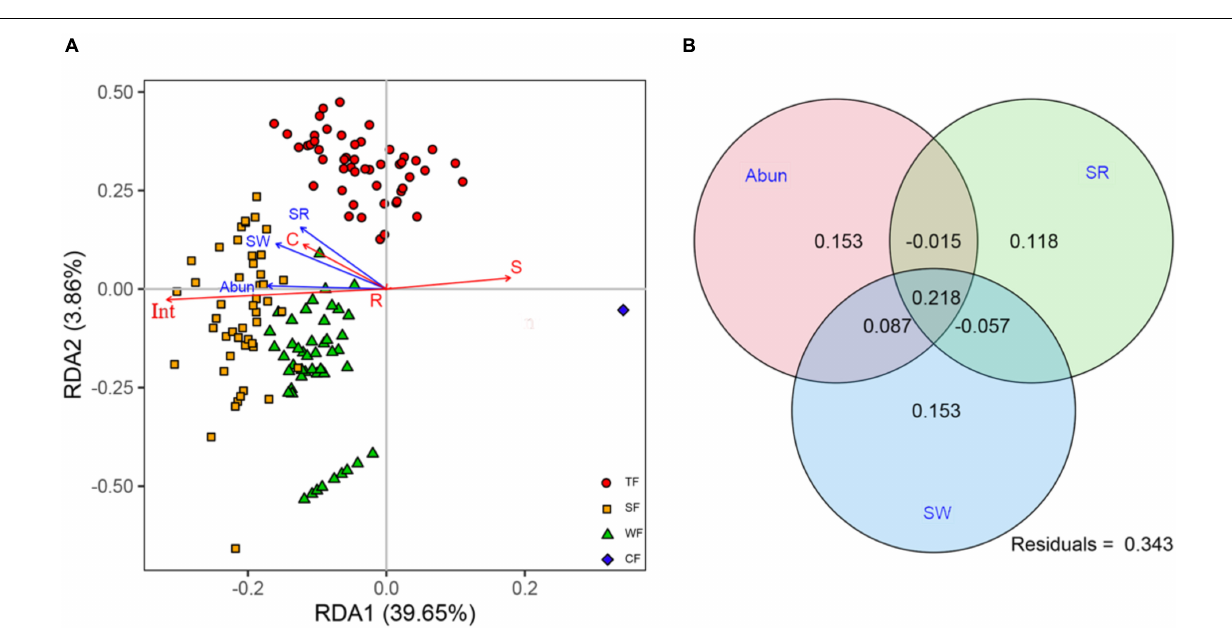
FIGURE 3 | (A) Redundancy analysis (RDA) for ecological strategy spectra and biotic factors (blue arrows): stem abundance (Abun), species richness (SR), Shannon-Wiener index (SW). Symbols in different colors and shapes indicate species in different forest types: TF, tropical forest (red circles); SF, subtropical forest (yellow squares); WF, warm-temperate forest (green triangles); and CF, cold-temperate forest (blue diamonds). Ecological strategy group abbreviations (red arrows) are as follows: C, competitors; S, stress-tolerators; R, ruderals; and Int, Int-strategists. (B) Venn diagram showing variation partition analysis that partitions relative contributions of Abun, SR, and SW to ecological strategy